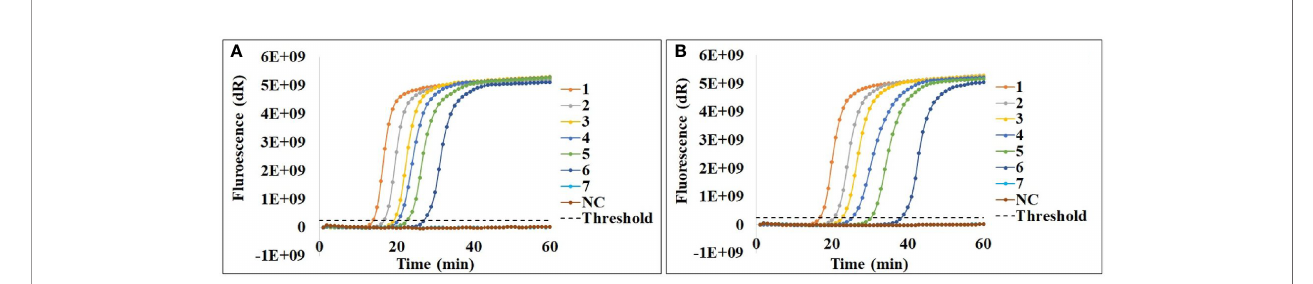
FIGURE 3 | Sensitivity of the Cod-UNG-rRT-LAMP assay containing (A) 0.3 mM dUTP and 0.05 mM dTTP and (B) 0.35 mM dUTP and no dTTP. In both (A) and (B) , a serial 5-fold dilution of a SARS-CoV-2 positive clinical sample was prepared. 1:5 times dilution, 2:25 times dilution, 3:125 times dilution, 4:625 times dilution, 5:3,125 times dilution, 6:15,625 times dilution, 7:78,125 times dilution, NC, negative control.